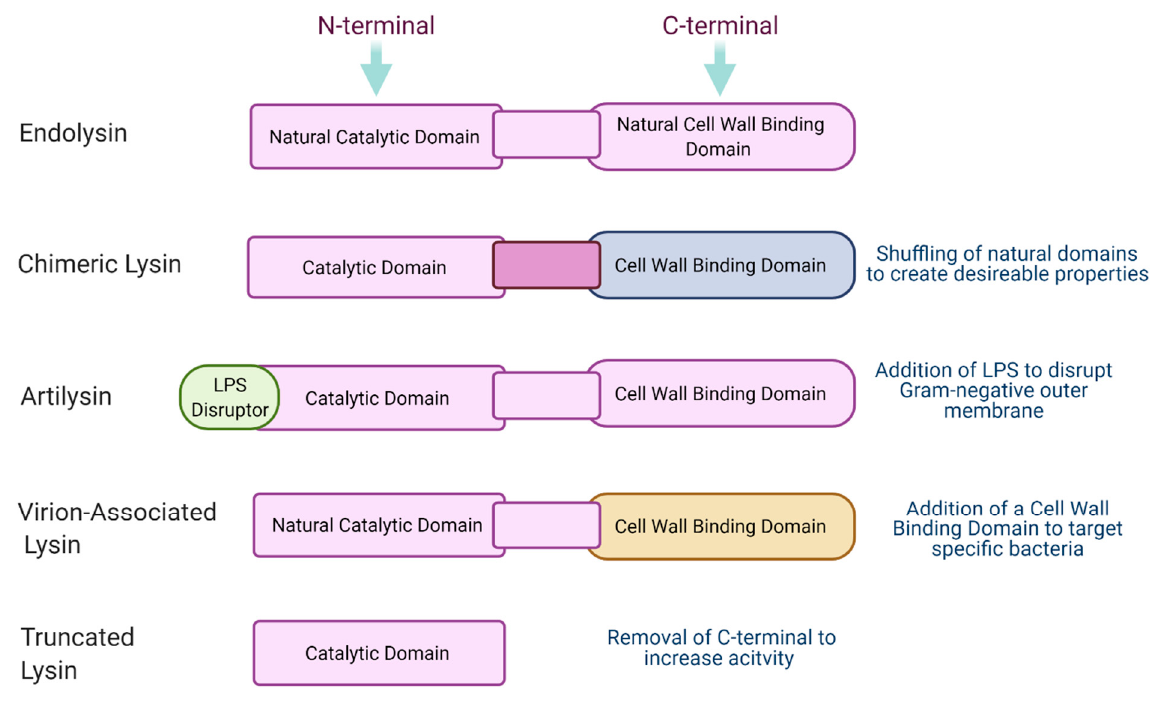
Figure 3. Next-Generation Lysins. This illustration shows the basic difference in structure between the following: natural endolysins, the engineered chimeric lysin which involves the linking of the catalytic domain of one lysin to a suitable cell wall-binding domain, the Artilysin which involves the fusion of an LPS disrupting molecule to a lysin, VALs which do not possess their own cell wall-binding domain and so are fused to a suitable candidate, and truncated lysins which have the cell wall-binding domain removed to increase activity.